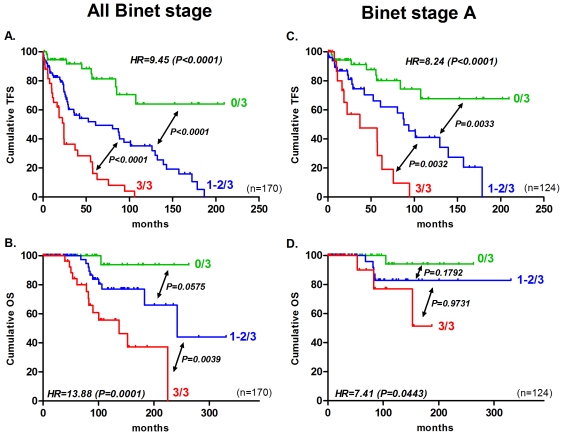
qPCR combining ZAP70, LPL and microRNA-29c stratifies CLL patients in terms of TFS and OS.TFS and OS, according to our qPCR score, were plotted with Kaplan-Meier methods for all Binet stages (A and B) and only Binet stage A (C and D). Curves were compared with the log-rank test (all Binet stages, n = 170; Binet stage A, n = 124). The hazard ratio (HR) was calculated with univariate Cox regression. Further information can be found in Table 1.